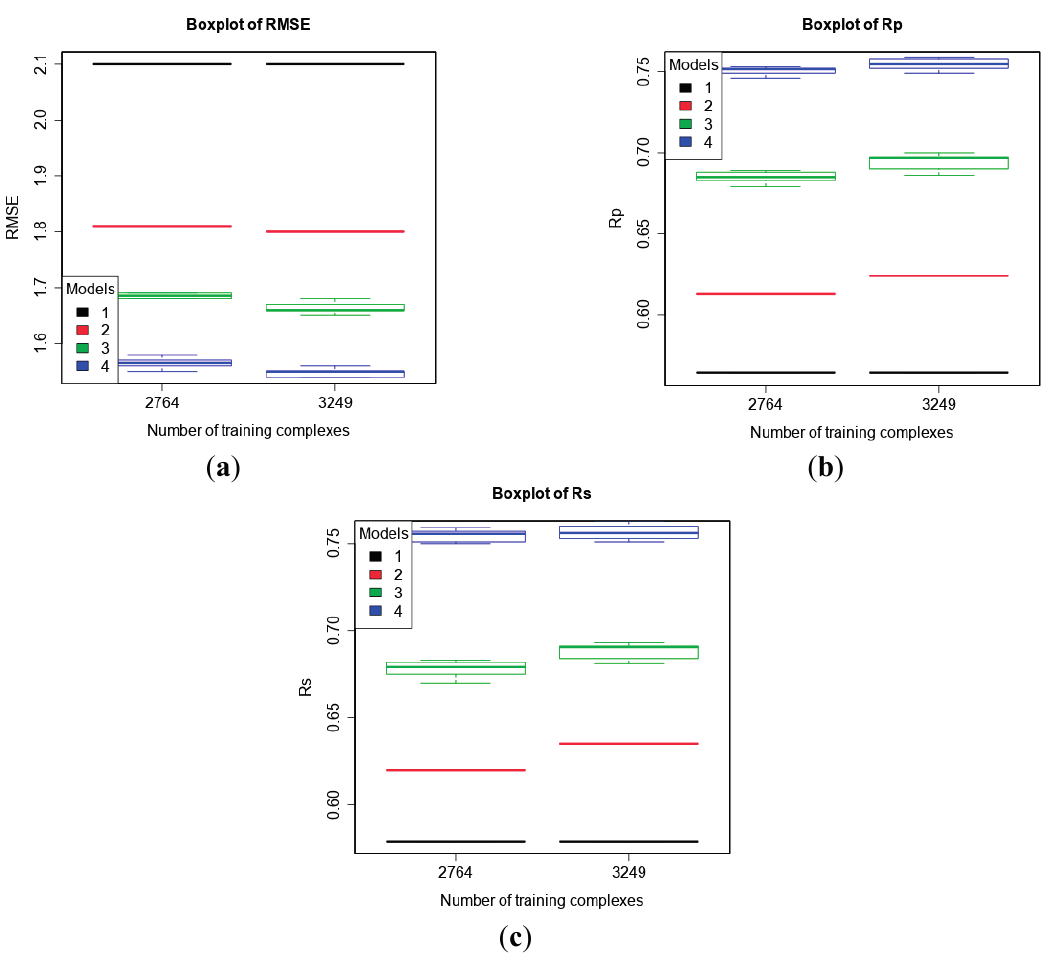
Figure 3. Performance of the four models trained on PDBbind v2013 refined set minus v2013 core set ( n = 2764) and v2014 refined set minus v2013 core set ( n = 3249) tested on v2013 core set ( n = 195) according to RMSE ( a ), R p ( b ), and R s ( c ). Models: 1 (Vina), 2 (MLR::Vina), 3 (RF::Vina) and 4 (RF::VinaElem).